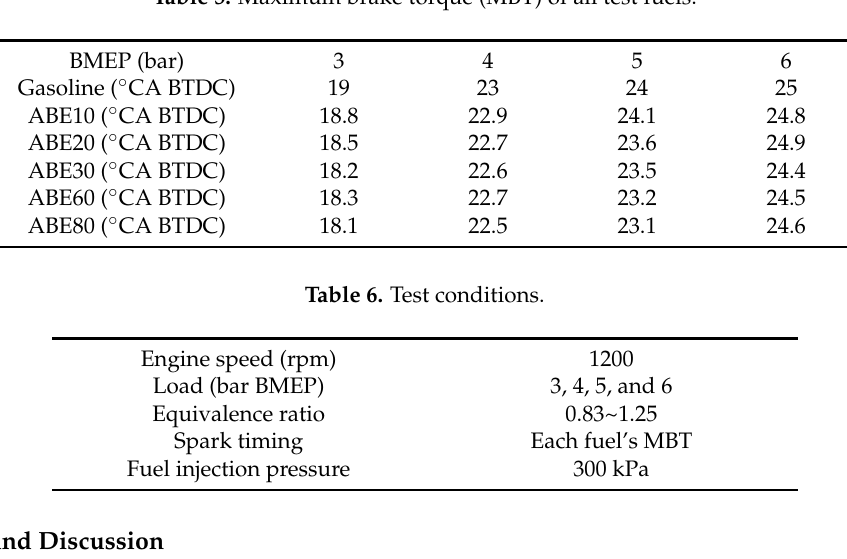
Table 5. Maximum brake torque (MBT) of all test fuels.